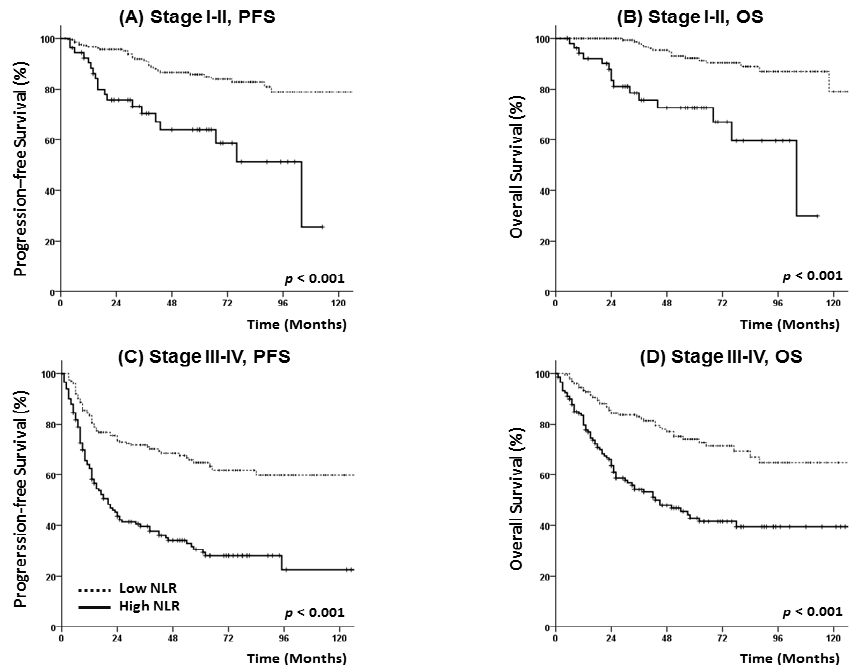
Figure 2. Progression-free survival and overall survival of patients with head and neck cancer at ( A , B ) stage I–II, and ( C , D ) stage III–IV.